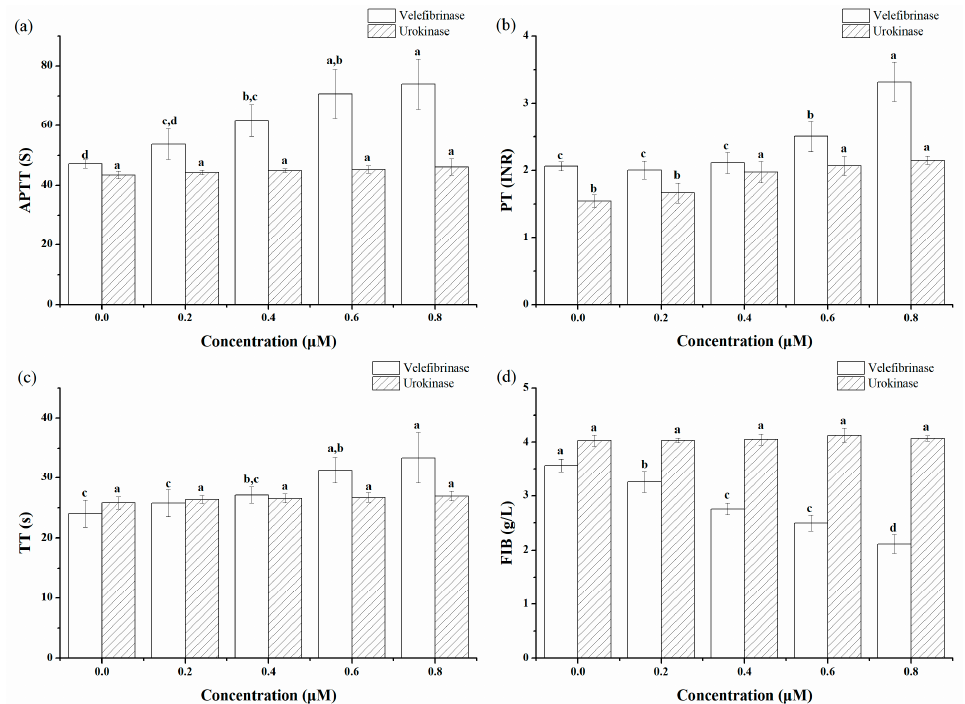
Figure 6. Determination of the anticoagulant activity in vitro. The effect of Velefibrinase and urokinase (0–0.8 μ M) on ( a ) activated partial thromboplastin time (APTT), ( b ) prothrombin time (PT), ( c ) thrombin time (TT), and ( d ) fibrinogen (FIB) in PPP. Data represent mean ± standard deviations (SDs) of triplicate experiments. Different letters indicate signif- icant differences ( p < 0.05) in each group.